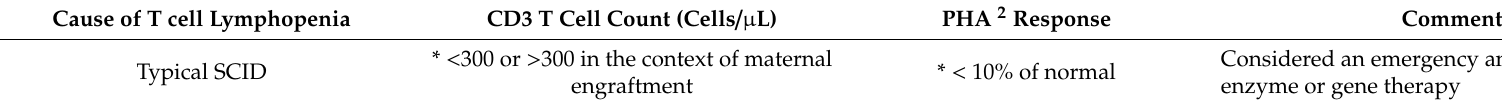
Table 1. CD3 T cell counts and functional analysis in T cell lymphopenic conditions identified by NBS SCID 1